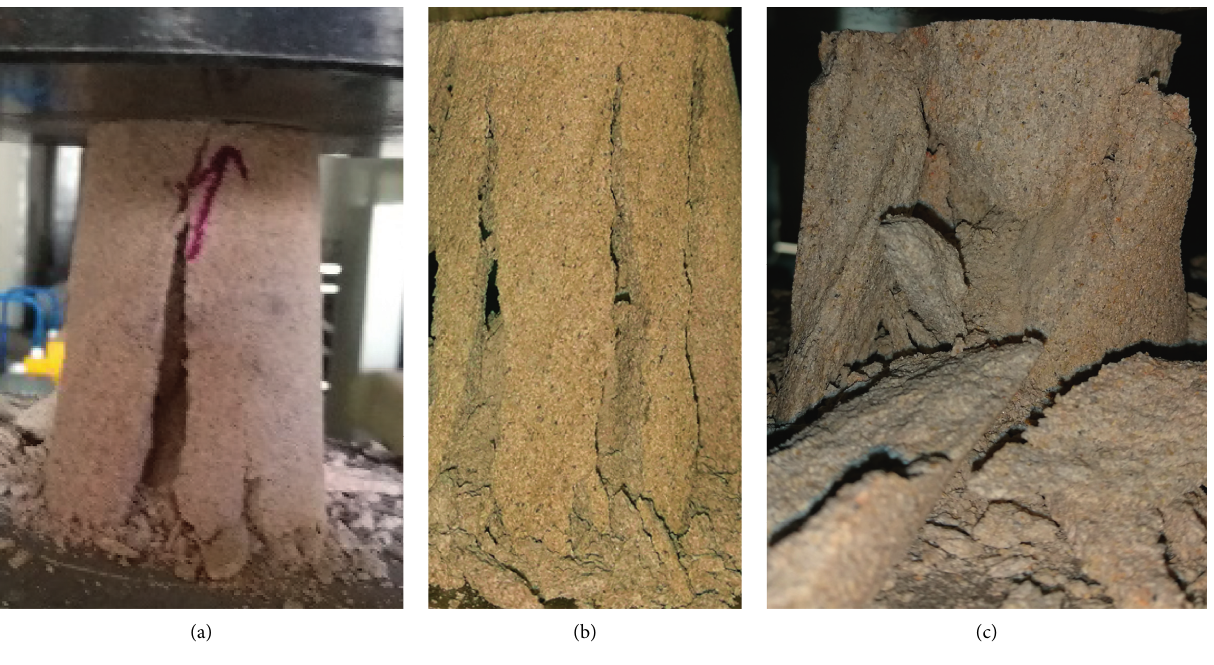
Figure 5: Damage form of (a) W1, (b) R2, and (c) R3.